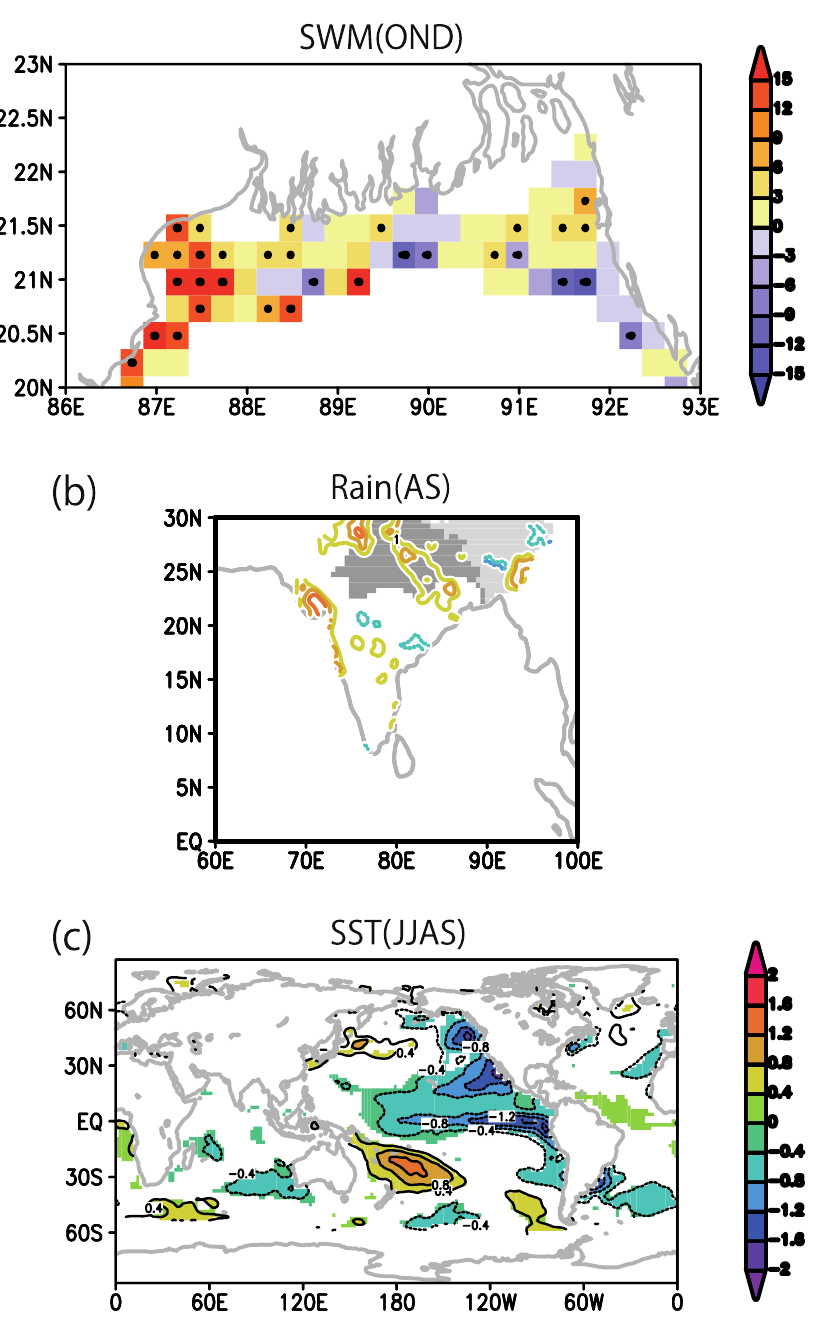
Figure 7. Composite map of high-Satellite Water Marker (SWM) over northern BoB in 2006–2017 (period of significant ENSO-monsoon relationship, see Figure 5). Composite map defined by high and low (exceeding ± 1 σ ) years of October–December (OND) SWM index over the north BoB (20–23 ◦ N, 85–95 ◦ E). ( a ) SWM anomalies in OND, ( b ) normalized August–September (AS) rainfall anomaly (only ± 1 σ , ± 1.5 σ . . . are contoured), and ( c ) same season June–September (JJAS) SST anomaly. Only areas above 90% significance are shown.